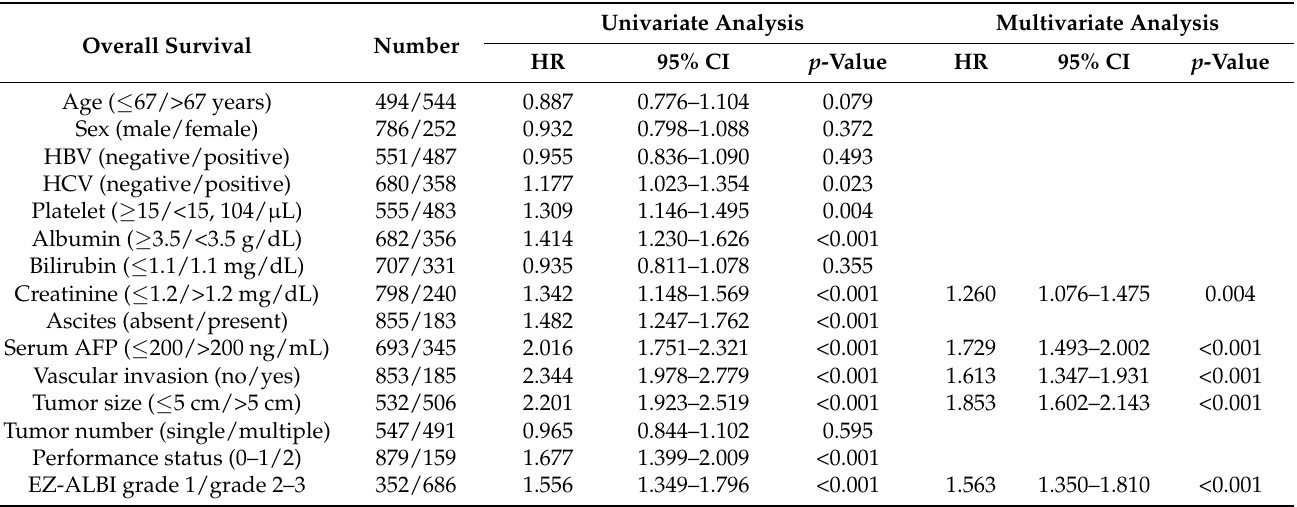
Table 4. Multivariate analysis of overall survival in patients undergoing transarterial chemoemboliza- tion including EZ-ALBI